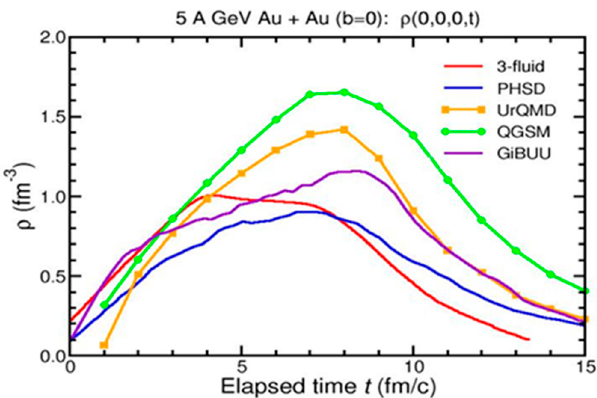
Figure 1. Net-baryon density versus time reached in a central Au + Au collision at 5 A GeV beam energy according to various transport codes and a hydro-dynamical calculation [6].